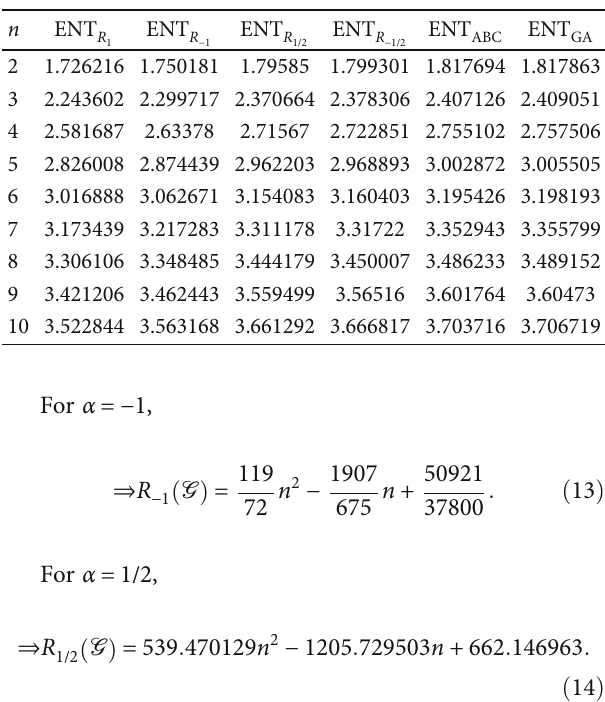
Table 2: Comparison